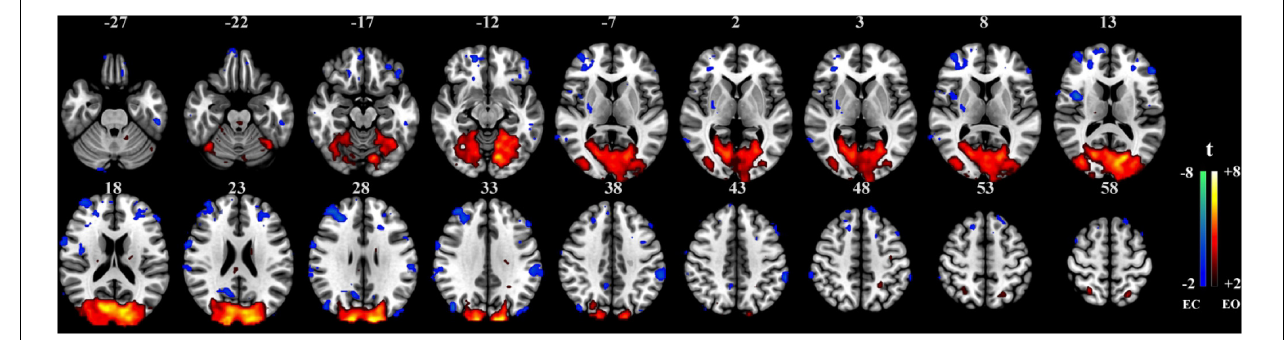
FIGURE 4 | Paired t -test SCM maps between the EC and EO resting-state conditions ( n = 45, t value > 2.0, p < 0.05, FDR